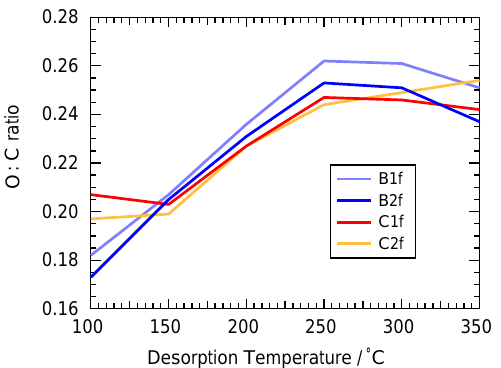
Figure 5. Measured oxygen-to-carbon ratios (O:C) of α -pinene SOA desorbing from filters at different temperatures.